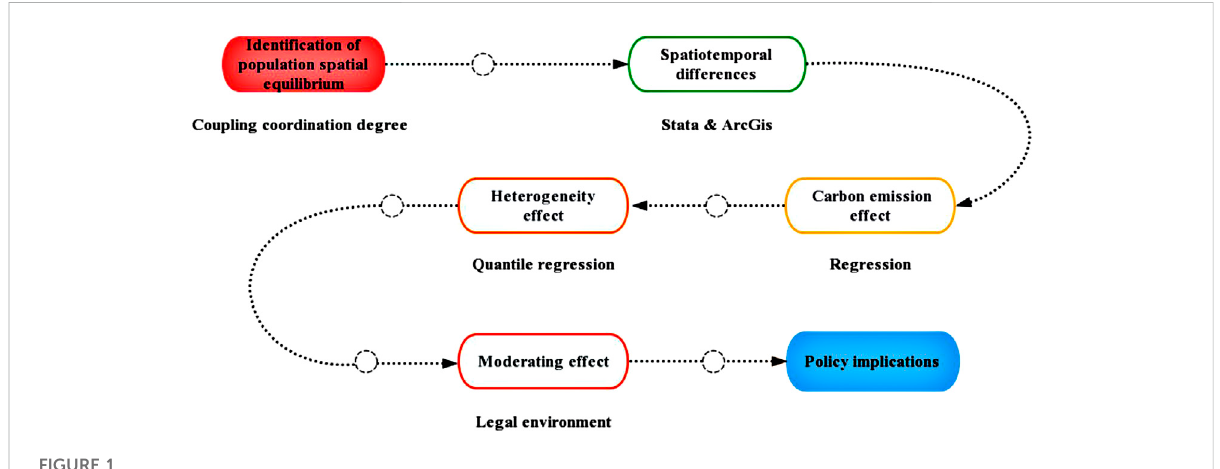
FIGURE 1 The logical framework for this